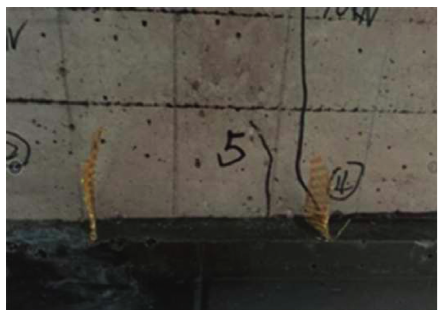
Figure 7: Voltage pole spacing.